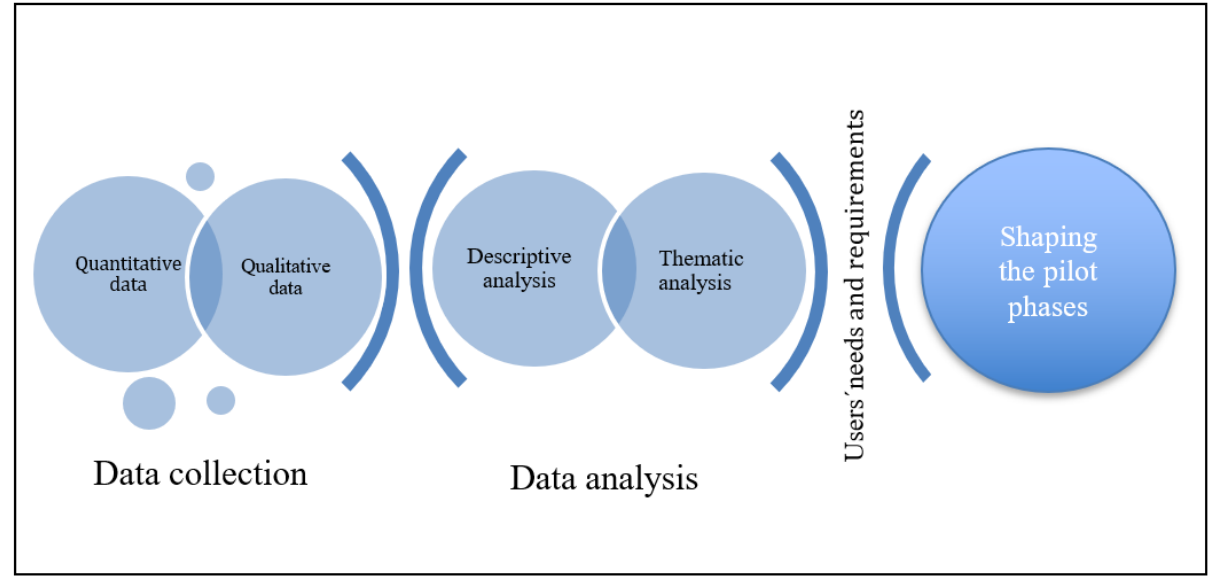
Figure 4. The process of investigating the users' needs and requirements. Qualitative and quantitative data were collected and analyzed using thematic and descriptive analysis methods. The identified results will be used to shape the pilot phases of the PROCare4Life project. PROCare4Life: Personalized Integrated Care Promoting Quality of Life for Older